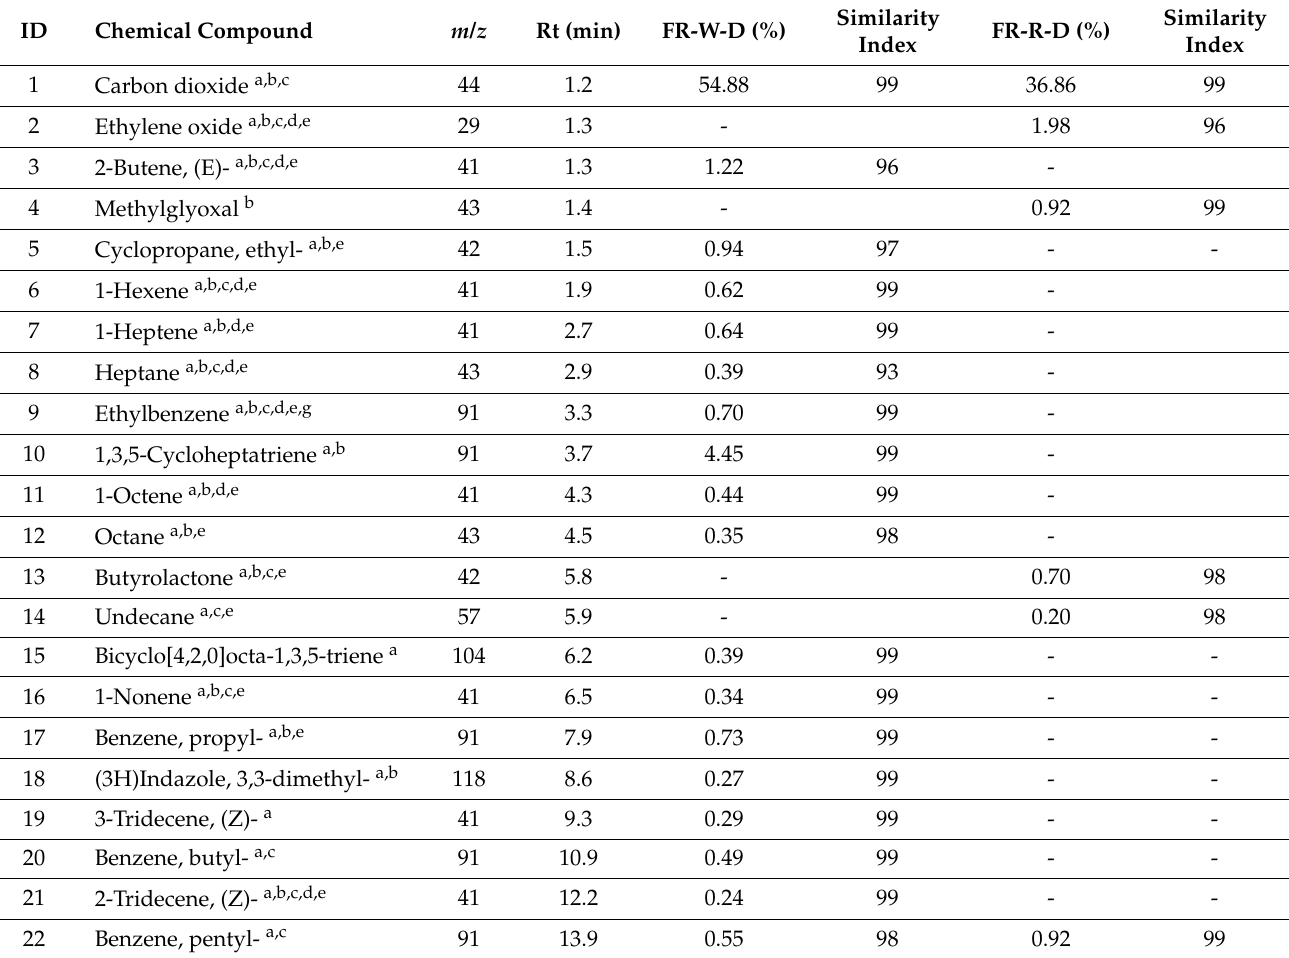
Table 7. Results of the analysis of FR pyrolysis products after washing in detergent and subse- quent